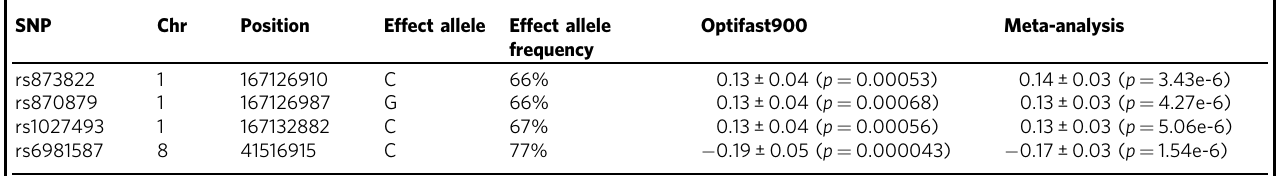
This table present single-SNP association p -values for the two cohorts and their meta-analysis for the top risk variant SNPs. Beta coef fi cients, with their standard error and p -value are provided, as estimated by the linear mixed effect model. Positive betas indicate that the effect allele associates with greater weight loss. Source data are provided as a Source Data fi